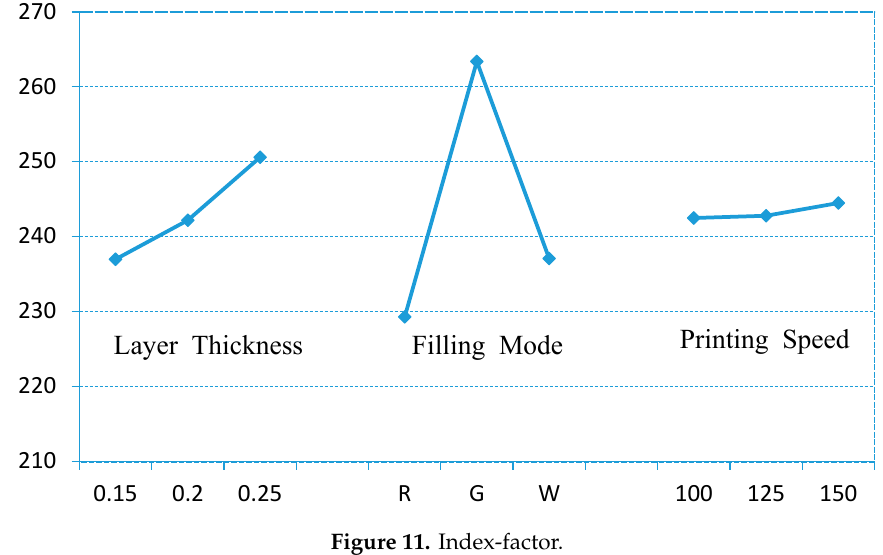
Figure 11. Index-factor.